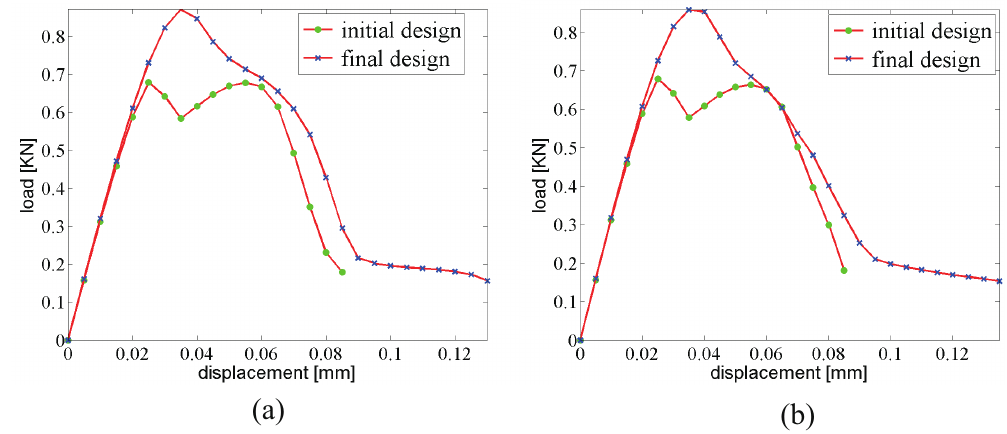
Figure 21. Fracture resistance comparison of two composites with initially randomly distributed inclusions, subjected to ( a ) loading case 1; ( b ) loading case